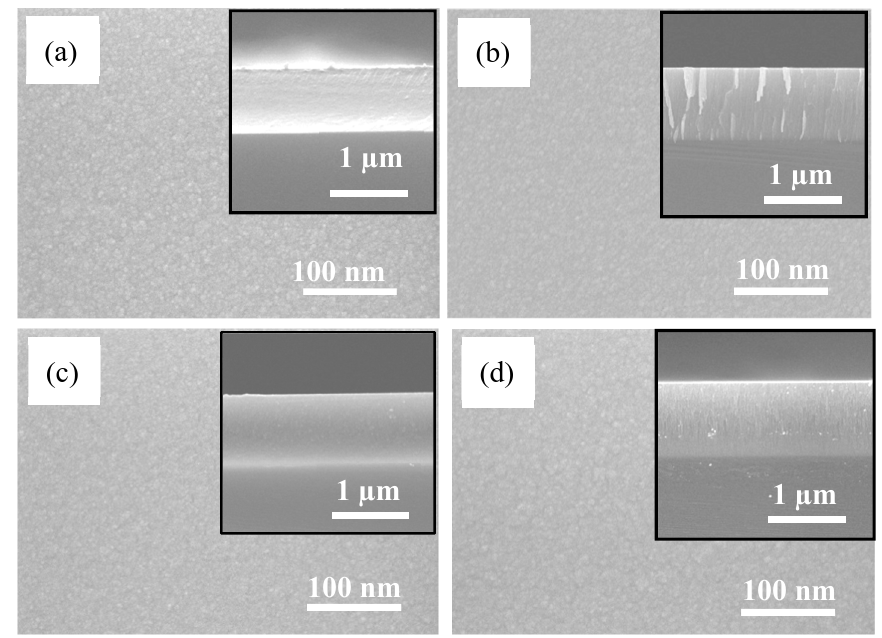
Figure 1. SEM images of Sb-0.14-GaN films sputtered at different heating substrate temperatures: ( a ) 100 ◦ C, ( b ) 200 ◦ C, ( c ) 300 ◦ C and ( d ) 400 ◦